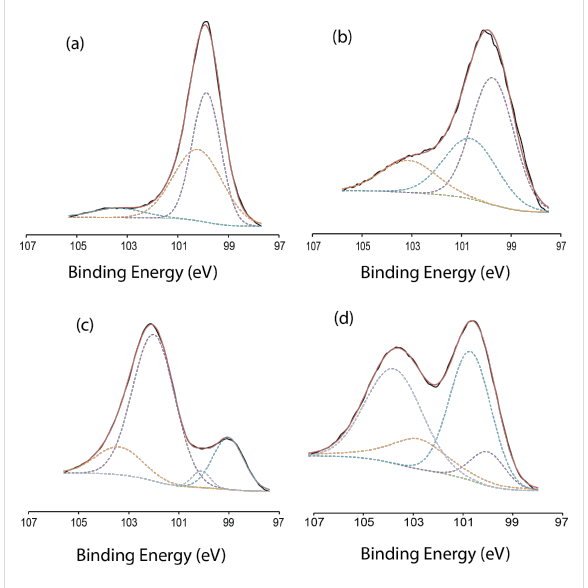
Figure 2: High-resolution XPS Si 2p spectra of the surface (a) ther- mally functionalized with trifluoroalkyne, (b) functionalized with tri- fluoroalkyne through UV-irradiation, (c) thermally functionalized with ethynylbenzyl alcohol and (d) functionalized with ethynylbenzyl alcohol though